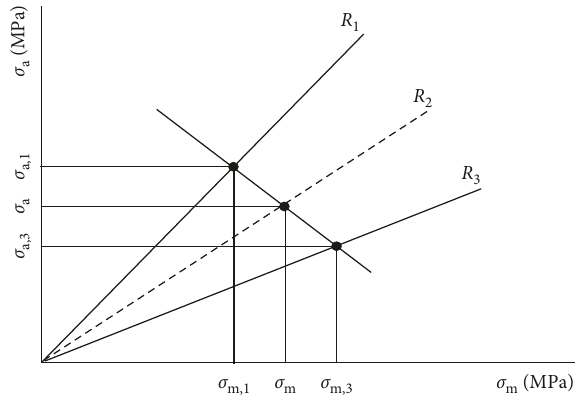
Figure 1: Illustration of the linear interpolation